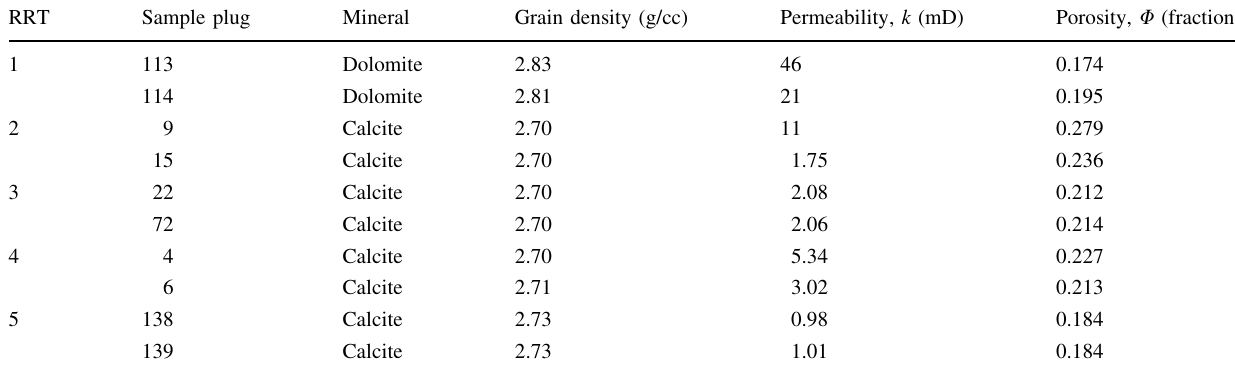
Table 4 Summary of core plug samples characterization